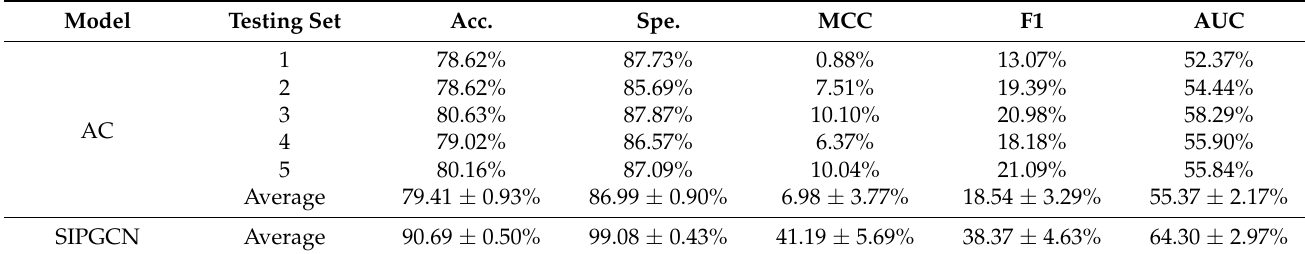
Table 6. Comparison of SIPGCN with the AC feature model in the yeast data set.